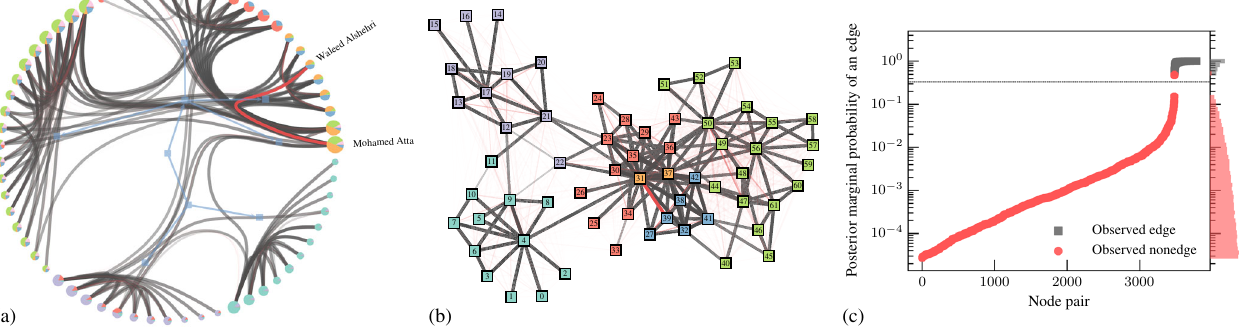
FIG. 2. Network of social associations between 9 = 11 terrorists [25,26]. This network is measured by potentially unreliable means, but no quantitative error estimates are known, and no repeated measurements were made. In (a) and (b) is shown the inferred network according to our method — which does not require direct error estimates or repeated measurements — where the edge thickness indicates the posterior marginal probability of an edge existing. In (a), the inferred hierarchical structure is shown, with pie charts on the nodes indicating the marginal probabilities of group memberships, and, in (b), a spatial layout of the same network shows the lowest level of the hierarchy as the node colors. The edge shown in red is inferred as existing with a large probability, despite not being measured. Other potentially missing edges are also shown in red, with a probability given by their thickness and opacity. In (c) is shown the marginal probability of edge existence for all node pairs, indicating a fair amount of inferred reliability — with the exception of the single missing edge highlighted in (a) and (b) — despite the lack of direct error estimates in the data. The horizontal line marks a 1 = 3 probability as a visual aid. The missing edge corresponds to a connection between Mohamed Atta and Waleed Alshehri, which is not considered in Refs. [25,26] but is corroborated by reports that they shared an apartment in Berlin and met previously in